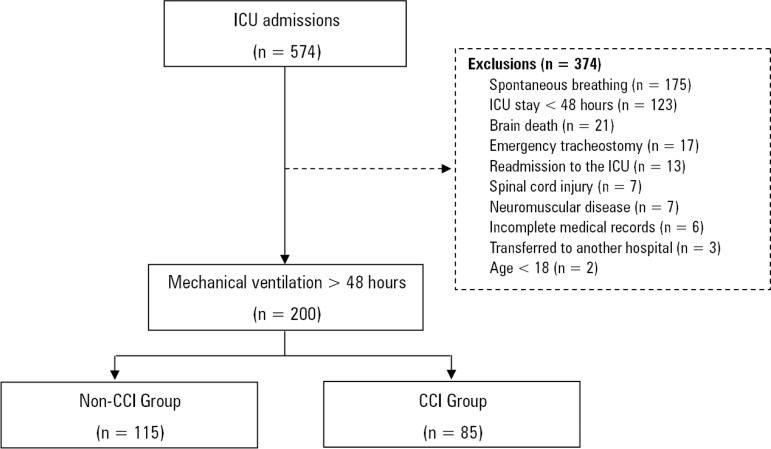
Study flowchart. ICU - intensive care unit; CCI - chronic critical illness.